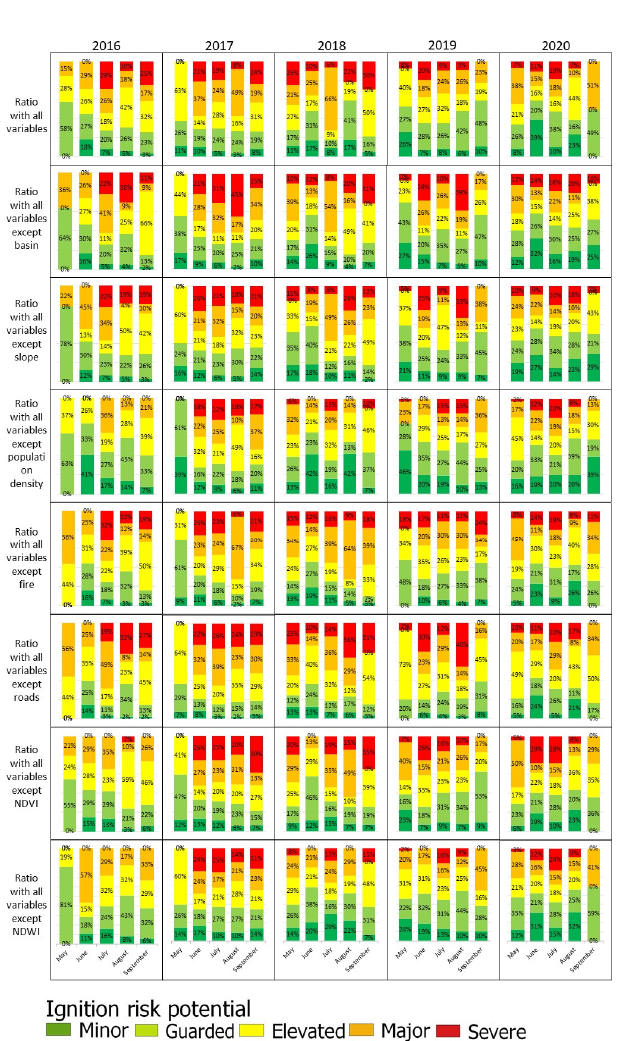
Figure A2. The c omparative model results of the analysis of the variables influencing the model. Figure A2. The comparative model results of the analysis of the variables influencing the